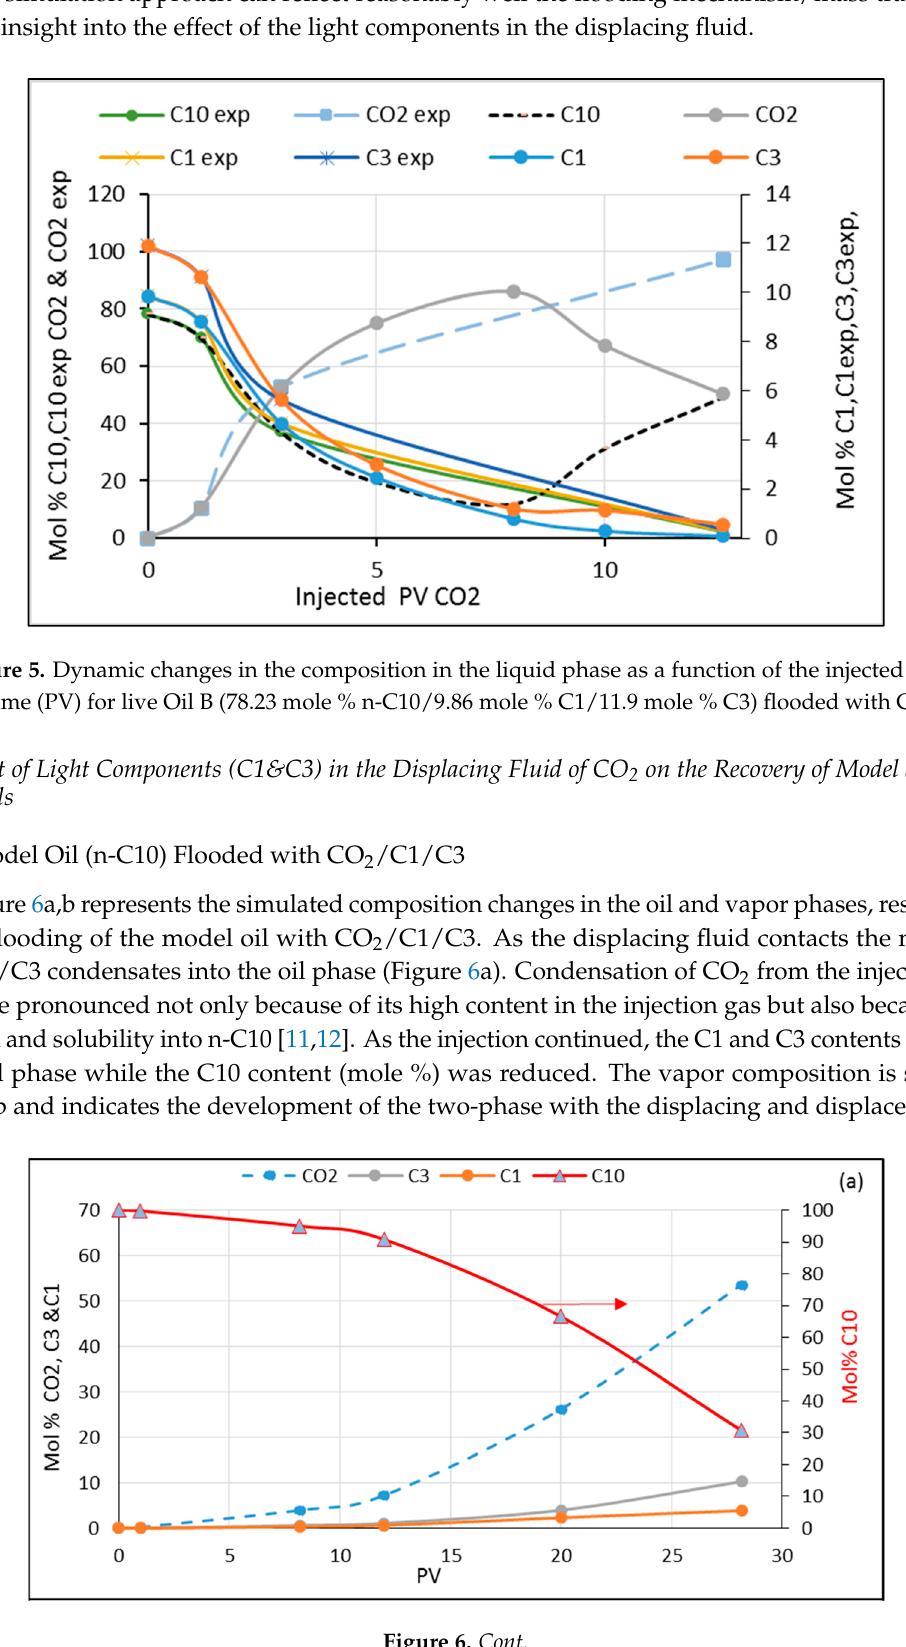
Figure 6. Cont . Figure 6.